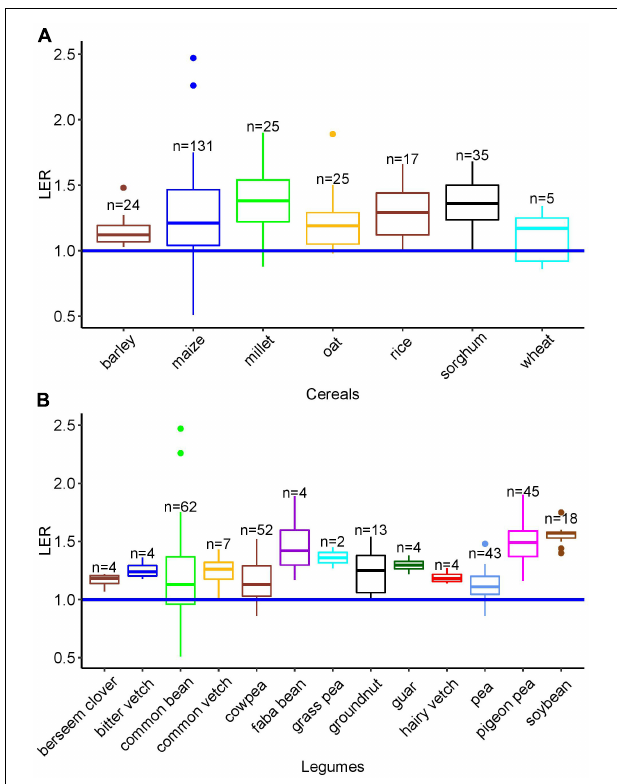
FIGURE 3 | (A) LER of intercropping systems with different cereal components. (B) LER of intercropping systems with different legume components. Extracted from 35 studies with median (horizontal line), upper and lower quartiles (boxes), and 1.5 interquartile range (IQR) (whiskers). The horizontal blue line was drawn at LER = 1; n : number of data points. Although wheat, faba bean, berseem clover, bitter vetch, hairy vetch, and guar data were excluded from the ANOVA ( n < 5), the data are shown in this graph for comparison.